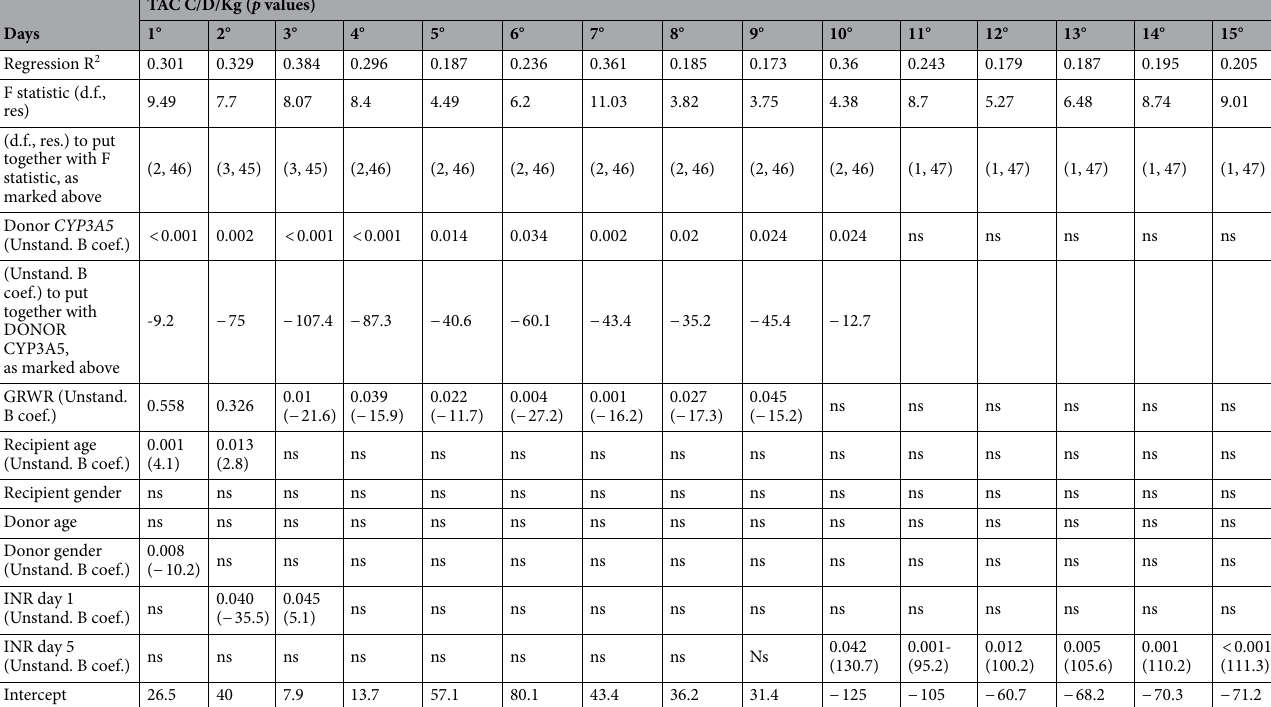
Table 3. Overview of the statistical significance of the predictive value of patients and graft characteristics for TAC concentration normalized by weight-adjusted dose (C/D/Kg). p values were calculated by multivariate linear regression analysis: only variables showing at least one significant p value by univariate analysis were included in the multivariate testing. NS = not significant and excluded from the model. CYP3A5 *1/*3 was coded as 1 while *3/*3 was coded as 2. GRWR was coded as